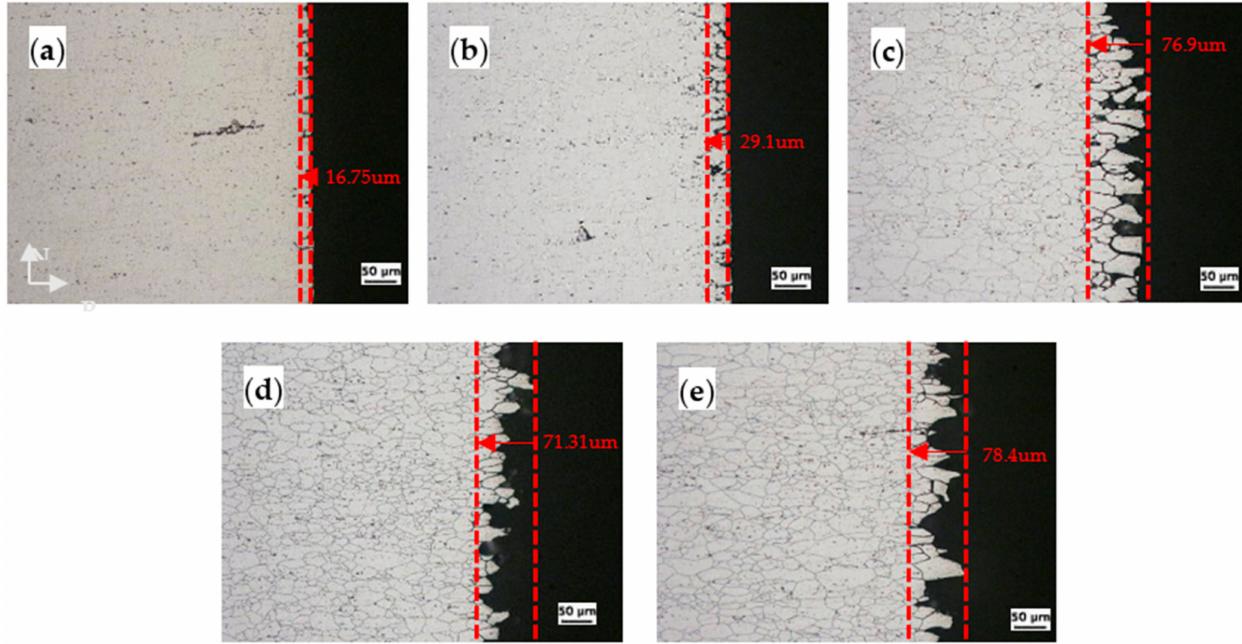
Figure 6. The surface of the CR20 alloy after NAMLT at different sensitization times: ( a ) 0 h, ( b ) 7 h, ( c ) 48 h, ( d ) 144 h, and ( e ) 207